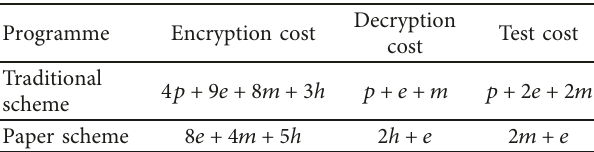
Table 2: Comparison of calculation cost between PKE +PEKS scheme and other schemes in this study.